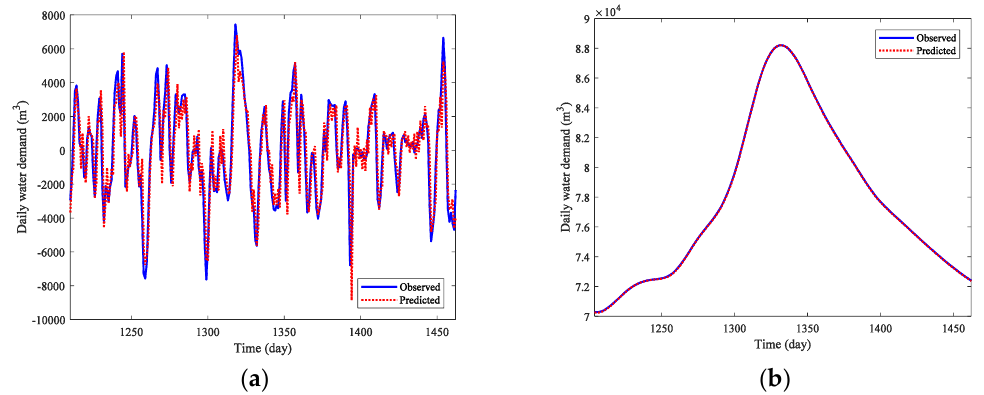
Figure 6. Forecasting results of the two feature terms: ( a ) stochastic term x sto ( t ) ; and ( b ) deterministic term x det ( t ) .